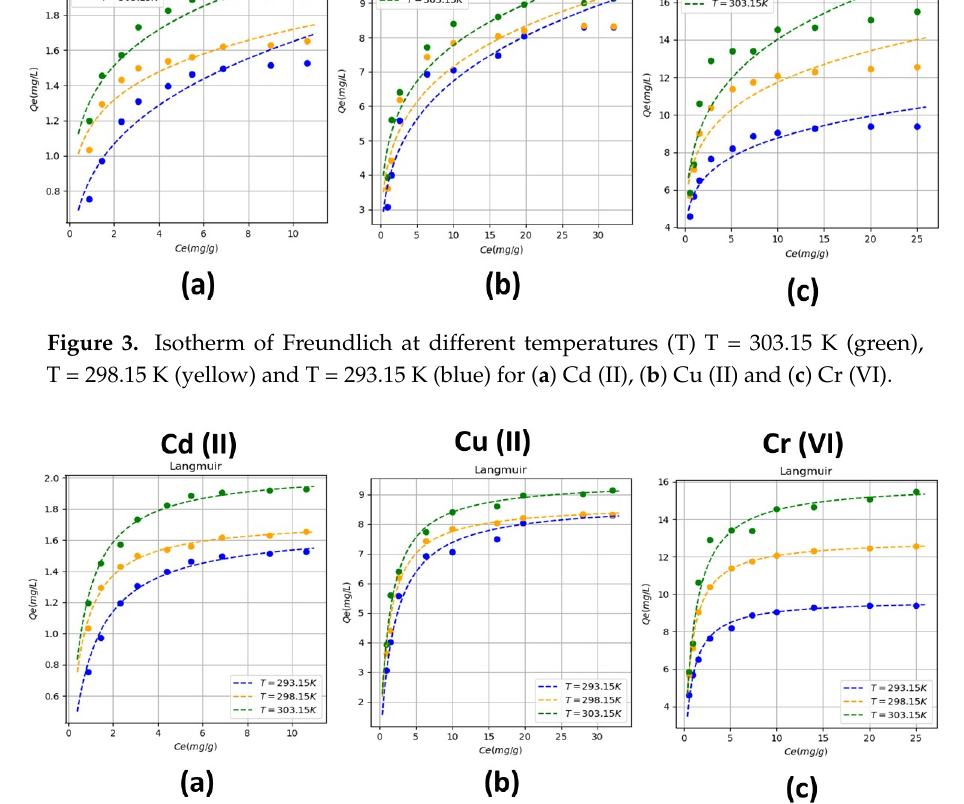
Figure 4. Isotherm of Langmuir at different temperatures (T) T = 303.15 K (green), T = 298.15 K (yellow) and T = 293.15 K (blue) for ( a ) Cd (II), ( b ) Cu (II) and ( c ) Cr (VI). Table 3. Langmuir and Freundlich parameters.